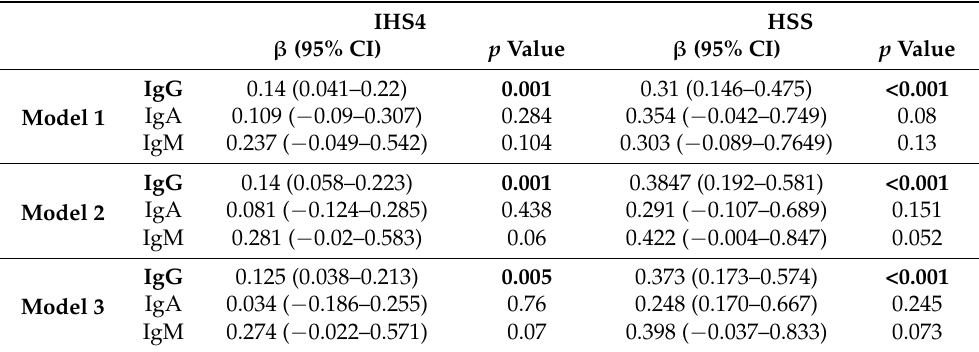
Table 2. Generalised linear models evaluating relationship between IgG, A and M level subtypes and International Hidradenitis Suppurativa Severity Scoring System (IHS4) and Hurley Severity Scoring (HSS) after adjusting for Models 1, 2 and 3.